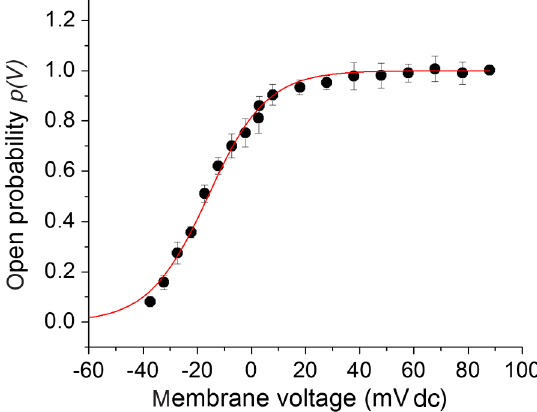
FIG. 2. Dependence of the open probability (the fraction of time the channel is open) on the membrane voltage. The open proba- obtained by bilityat voltage V ismeasuredfrom the peak current I 0 depolarizing the channels with a voltage step ending at V . The =V , plotted vs V and normalized to 1 at high V , is conductance I 0 shown inthefigure. The solid line is producedby a fitusingEq.(3). Here, as in the rest of the paper, the ion channel is the KvAP channel with the internalcysteineremoved(seeSection II),andthe symmetric salt conditions of 150 mM KCl are used. The data in the graph are from the same bilayer. The channels are closed with probability 1 below approximately (cid:2) 40 mV and open with proba- bility 1 above approximately þ 20 mV . In the neuron, the typical resting potential is (cid:2) 70 mV and the spike of the action potential is approximately 50 mV